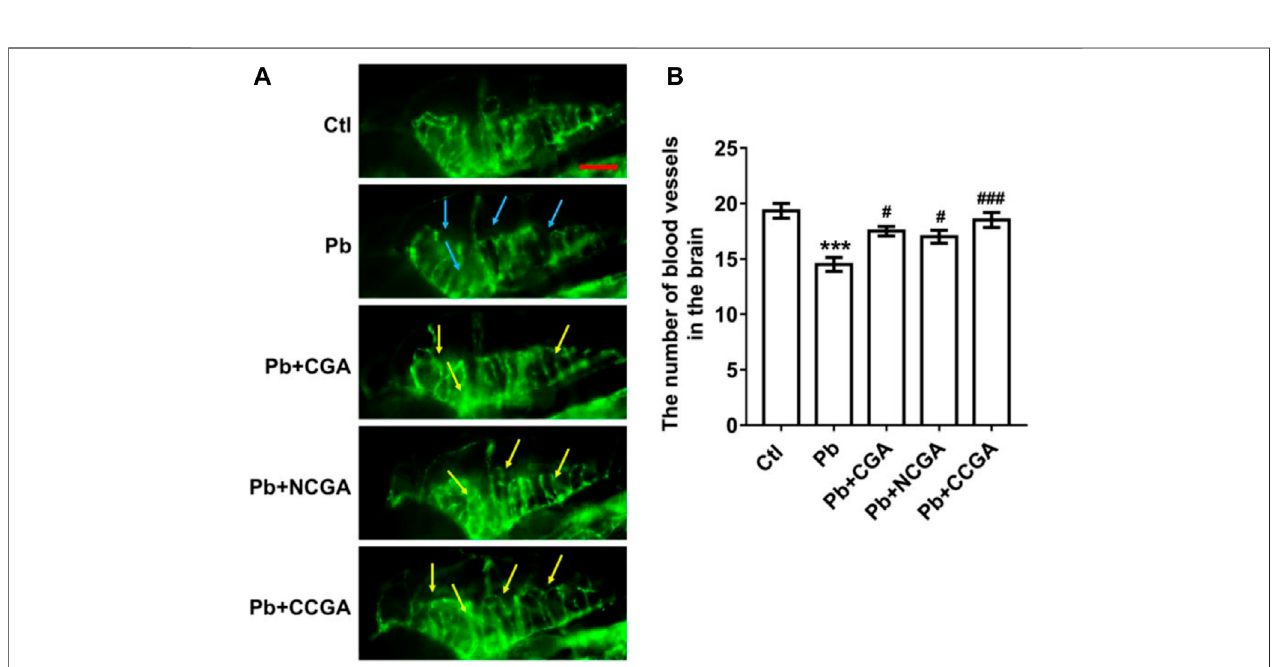
FIGURE 5 | Representative images of blood vasculature of zebra fi sh and its analysis. (A) Representative fl uorescence microscopy images of fl i1:GFP zebra fi sh at 120 hpf. Loss of vasculature was indicated by blue arrows. Recovery of vasculature was indicated by yellow arrows. (scale bar, 100 μ m). (B) Statistical analysis of the number of blood vessels in the brain ( n (cid:1) 6). *** p < 0.001 vs. control and # p < 0.05, ### p < 0.001 vs. Pb.